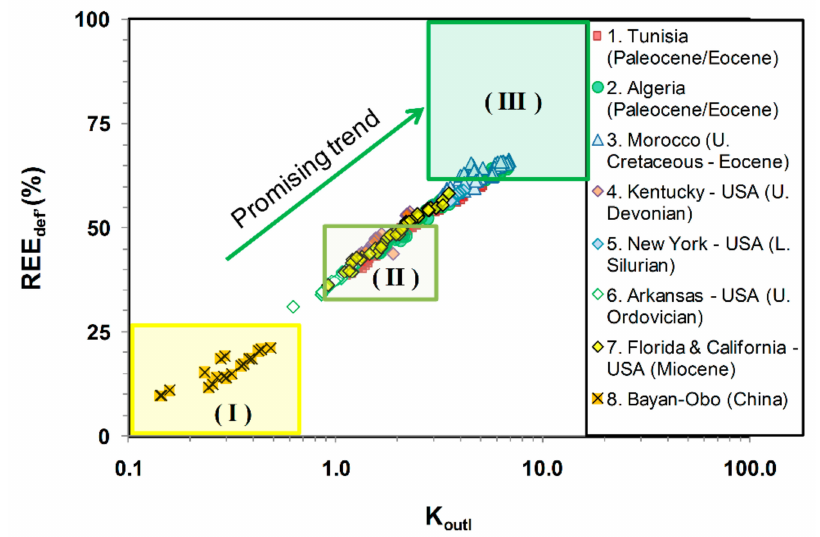
Figure 13. Classification of REE-bearing P-deposits based on outlook coefficient (K outl ) versus the percentage of critical elements in total REE (REE def ) [94]. I: unpromising (REE def ≤ 26% and K outl ≤ 0.7); II: promising (33% ≤ REE def ≤ 50; 0.9 ≤ K outl ≤ 3.1); III: highly promising (REE def ≥ 62% and K outl ≥ 2.8). Data source: (1) [9,10,12]; (2) [7,13]; (3) [11]; (4,5,7) [6]; (6) [90], (8)